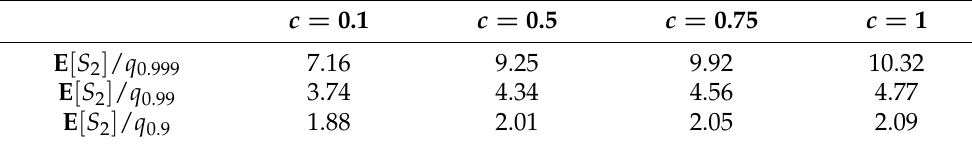
Table 3. The ratio of E [ S 2 ] / q γ .